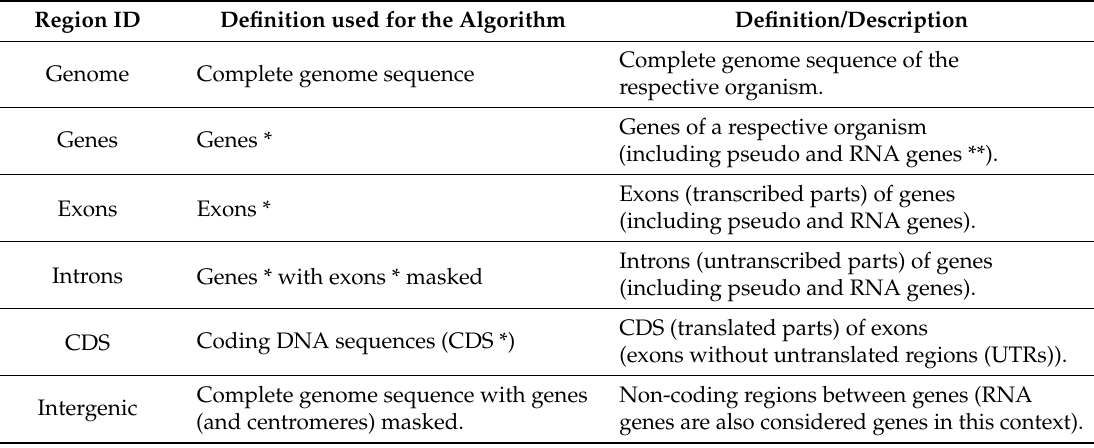
Table 2. Definitions of genome sequence